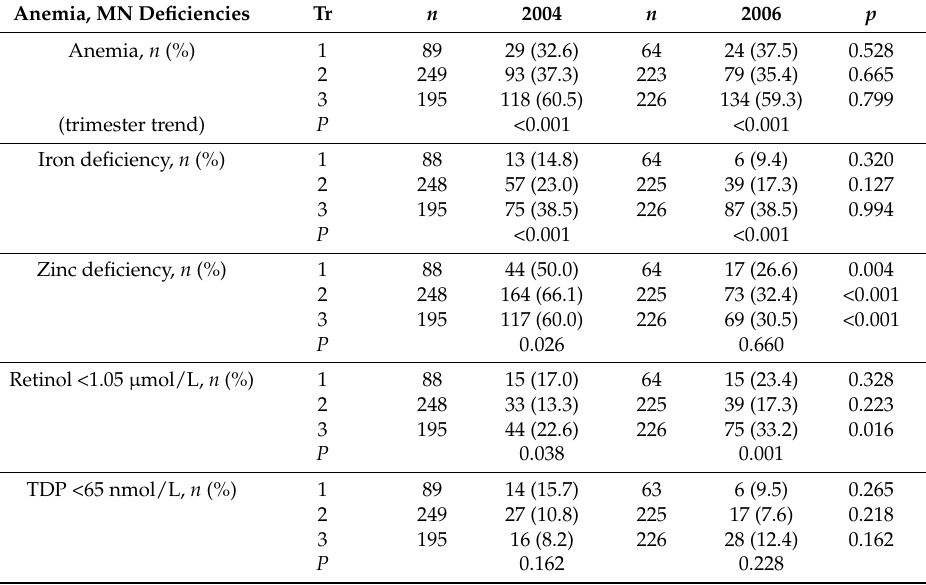
Table 4. Comparison of the prevalence of anemia and MN deficiencies between surveys 1 .